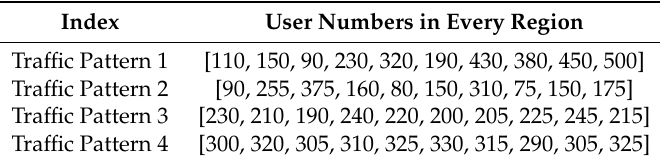
Table 2. Traffic patterns in the experiment.